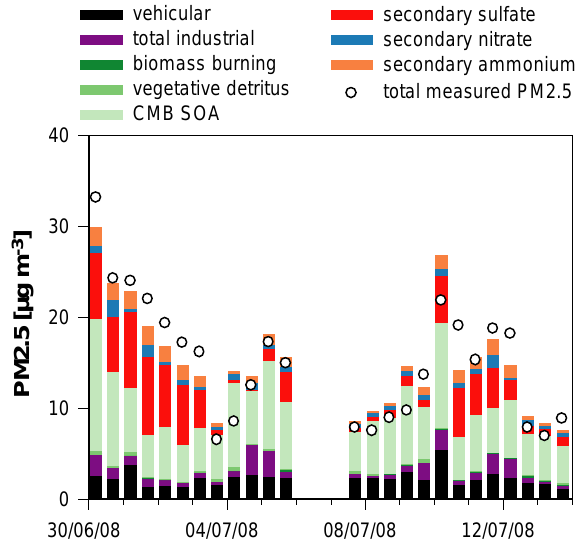
Fig. 12. Source contributions to fine particulate matter (PM 2 . 5 ) es- timated by CMB modelling. Also shown are the concentrations of PM 2 . 5 measured by TEOM-FDMS (white